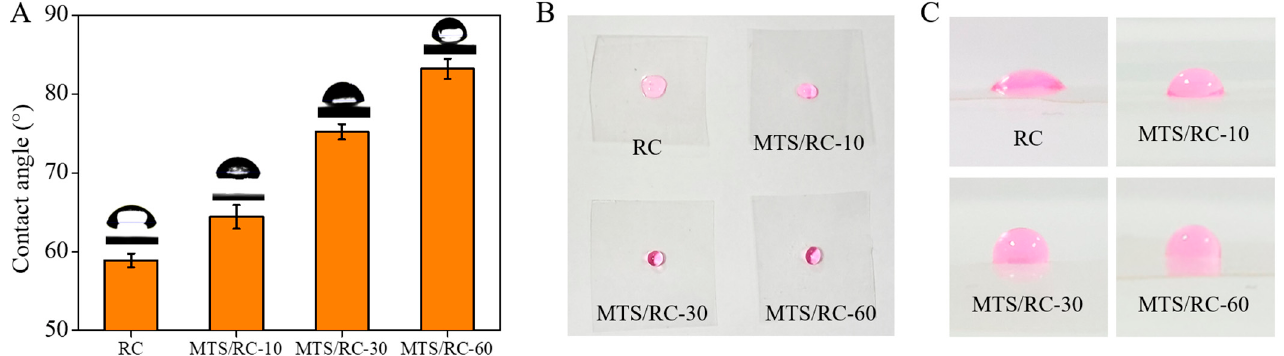
Figure 5. ( A ) Water contact angle values for the pristine RC film and the MTS/RC-10, MTS/RC-30, and MTS/RC-60 films. ( B , C ) Photographs of ( B ) the top and ( C ) the side of a 10 µL rhodamine-B-dyed water drop (10 mg/mL) that was dropped on the surface of the pristine RC film and the RC/MTS films.